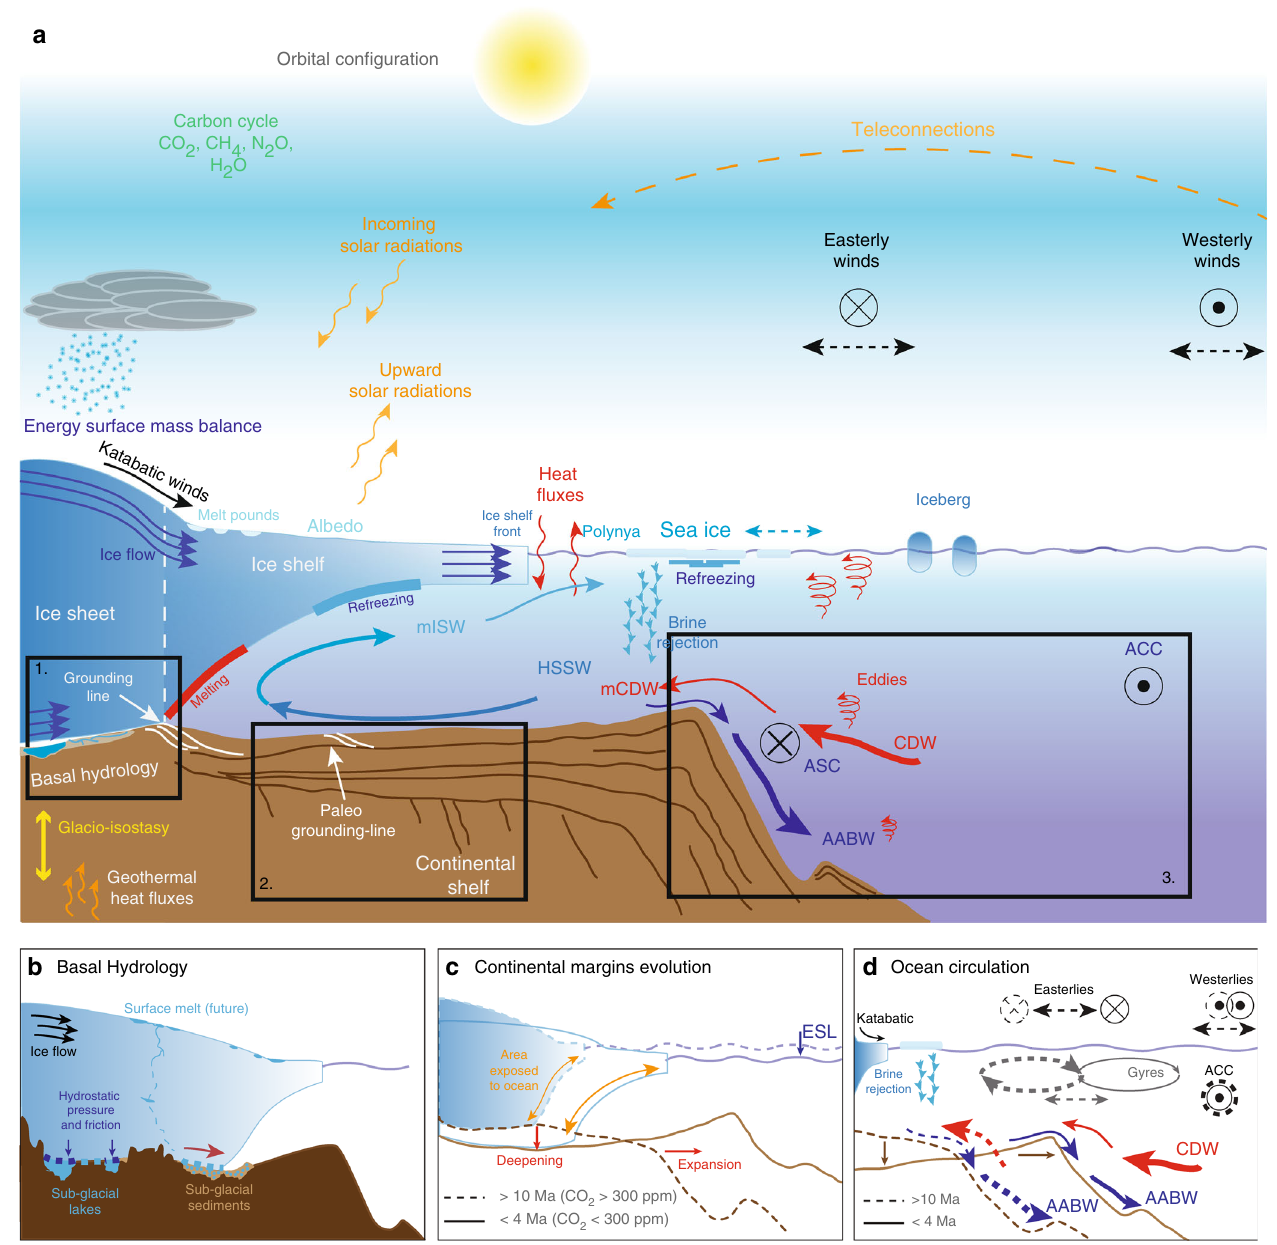
Fig. 1 Conceptual and simpli fi ed view of the Antarctic polar system. a The state-of-the-art and the knowledge gaps about subglacial hydrology (1), continental shelf evolution (2), and ocean circulation (3) are discussed in the present review. b Macro-scale (e.g., mountains and lakes) and micro-scale (presence of deformable sediments) subglacial bed roughness in fl uences the relationship between ice sheet and hydrological processes. Basal meltwater can saturate sediments, which helps to accelerating the ice fl ow and impacts on grounding line dynamics. c Geophysical records suggest that the modern sea fl oor reached its landward dipping morphology and extent by the late Miocene-early Pliocene ( ≈ 5 Ma), as a result of intense subglacial erosion. d Numerical simulations 89 suggest that a smaller Weddell Sea continental shelf, as during the mid Miocene ( ≈ 15 Ma) compared to modern, induces a poleward shift of regional oceanic circulation, and enhances heat transport (CDW/AABW) across the continental shelf edge. The depth and shape of the continental shelf edge and slope determine where the intrusions of CDW occur. The sub-cavity ocean processes and the glacio-isostatic adjustment will be discussed in upcoming reviews by Smith et al. (in preparation) and Whitehouse et al. (in preparation). AABW, Antarctic Bottom Water; ACC, Antarctic Circumpolar Current; ASC, Antarctic Slope Current; CDW, Circumpolar Deep Water; GL, Grounding line; HSSW, High Salinity Shelf Water; mCDW, modi fi ed CDW; mISW, modi fi ed Ice-Shelf Water. Note that the oceanic processes represented in 2D view for the purpose of the illustration might not occur at the same locations on the continental